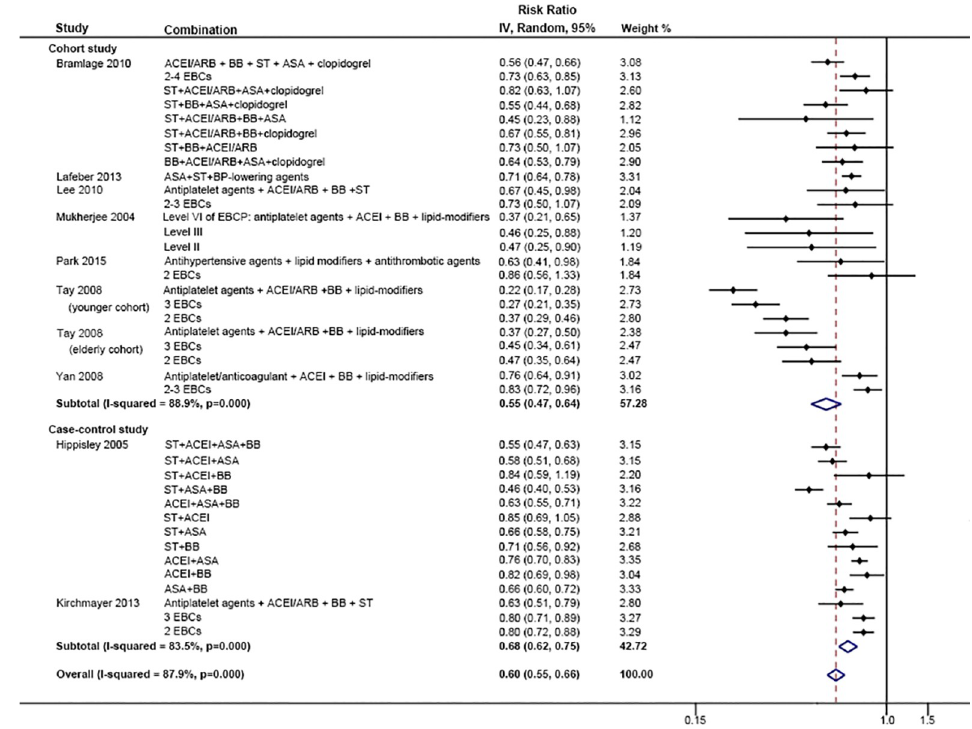
Fig 2. Comparison: EBCP versus 0–1 EB component, Outcome: All-cause mortality.